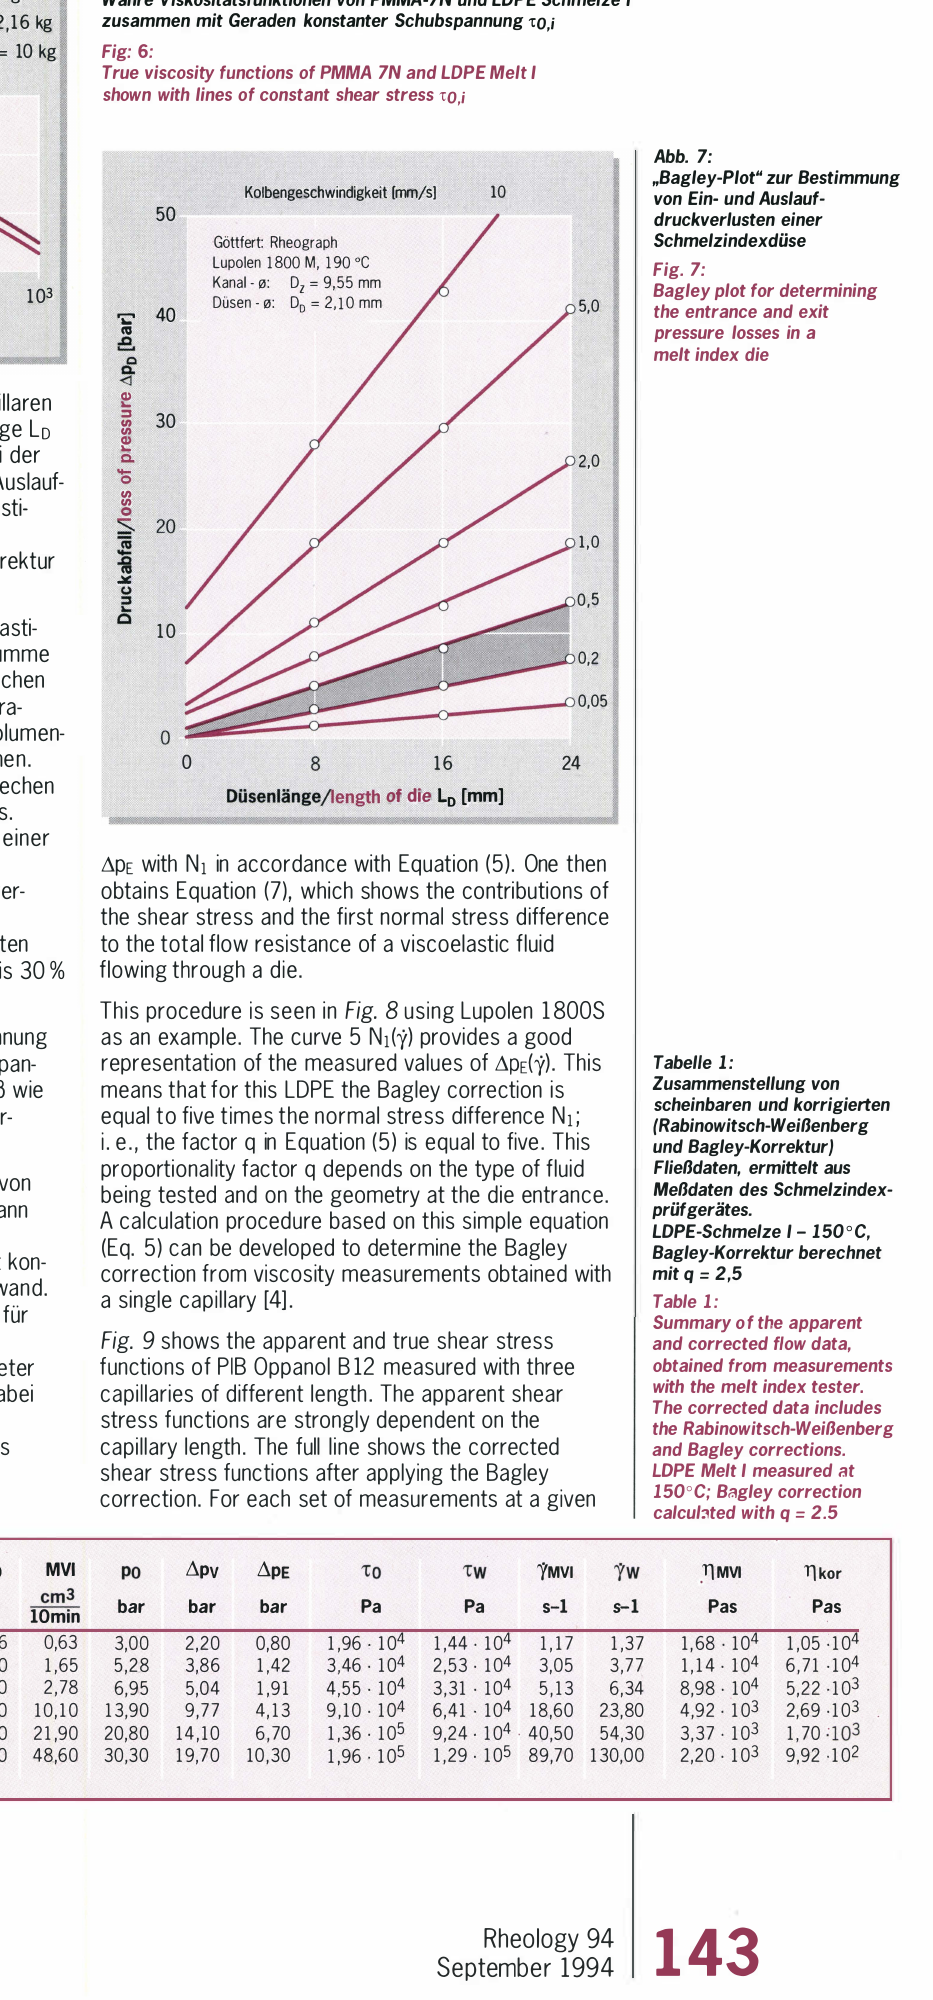
Fig: 6: True viscosity functions of PMMA 7N and LOPE Melt I shown with lines of constant shear stress �a.;